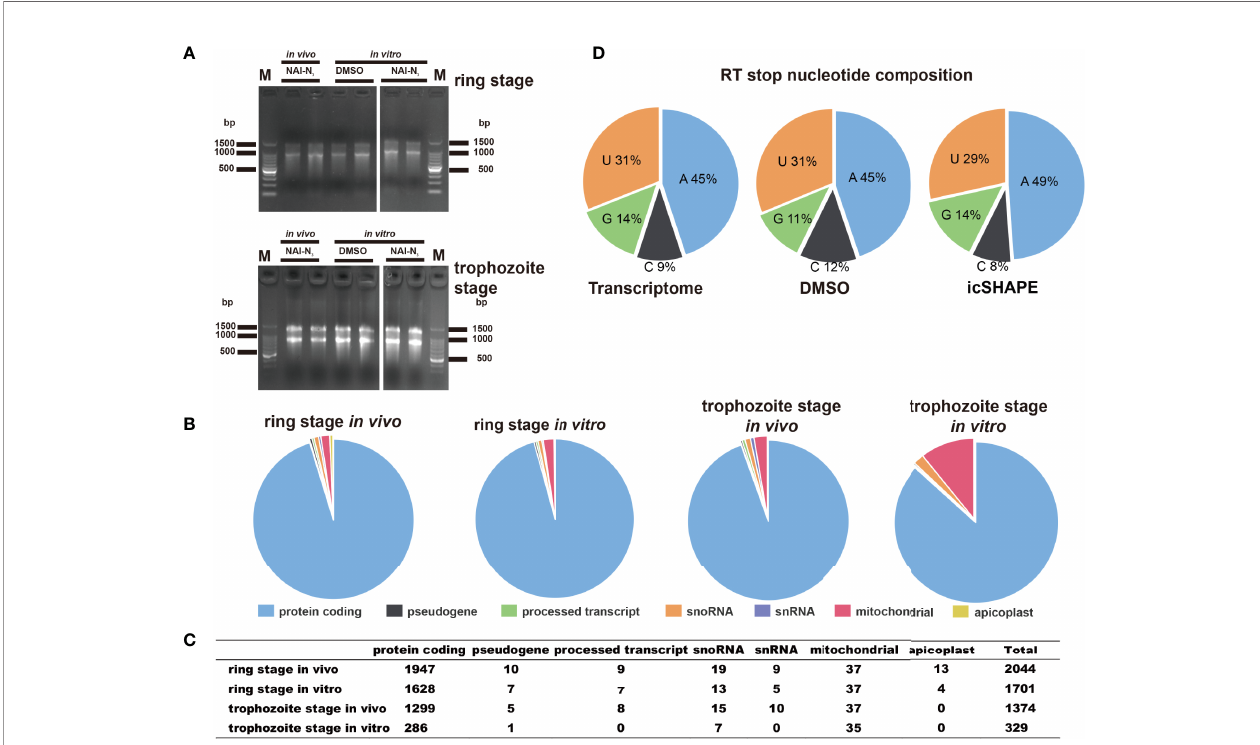
FIGURE 2 | icSHAPE is capable of measuring the RNA structure pro fi les of thousands of RNAs simultaneously in vivo and in vitro . icSHAPE is capable of measuring the RNA structure pro fi les of thousands of RNAs simultaneously in vivo . (A) Evaluation of RNA quality of two biological replicates between stages and conditions in vivo modi fi cation, in vitro modi fi cation, and DMSO control samples in agarose gel. (B, C) The total number of structural pro fi les for transcripts was classi fi ed into different classes of RNAs from a total number of 2044 transcripts for the ring stage library at 37 degree in vivo , 1701 transcripts for the ring stage library at 37 degree in vitro , 1374 transcripts for the trophozoite stage library at 37 degree in vivo , and 329 transcripts for the trophozoite stage library at 37 degree in vitro . This fi gure combines results from both two biological replicates. (D) Reverse transcription stop distribution for the whole transcriptome, DMSO-treated RNA control libraries or icSHAPE-treated RNAs libraries. All of the three stop distributions are highly concordant, icSHAPE in vivo treatment no enriches for any sequencing reads mapping to four bases compared to untreated control, except a slight enrichment in NAI-N 3 library for